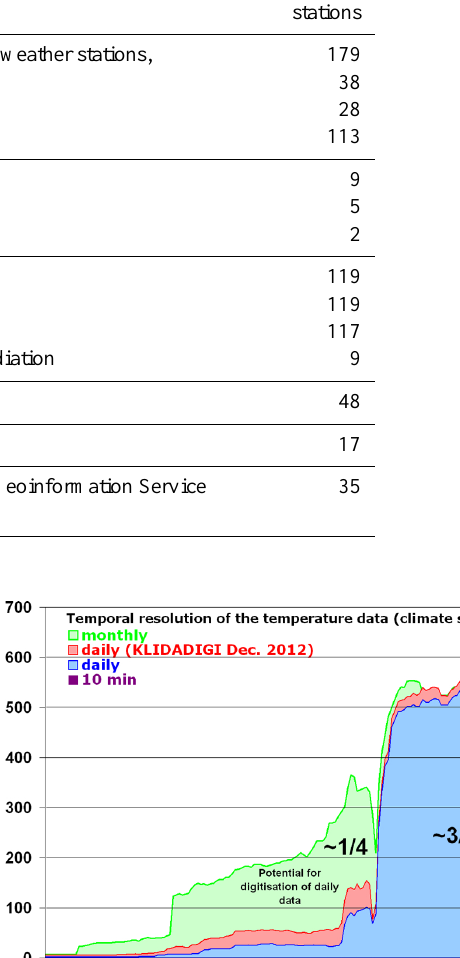
Table 1. The primary network of Deutscher Wetterdienst (as of 8 December 2012). Type of station